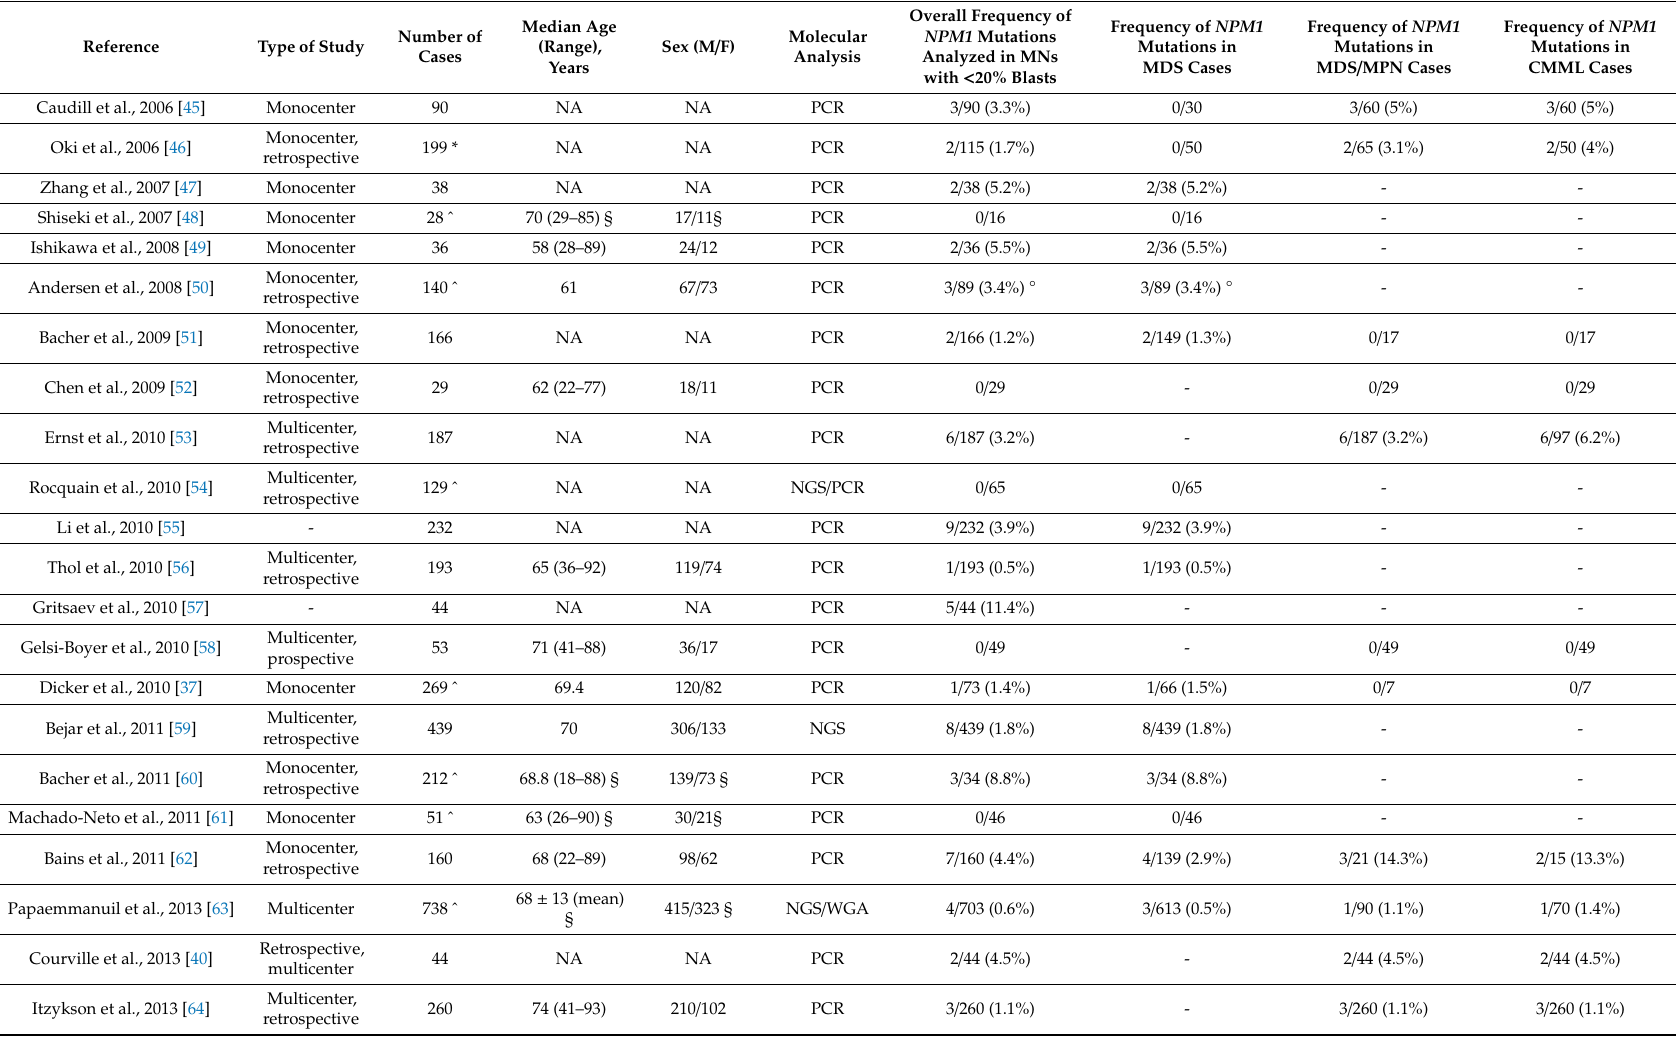
Table 1. Prevalence of NPM1 mutations in patients with MDS or MDS / MPN: review of the